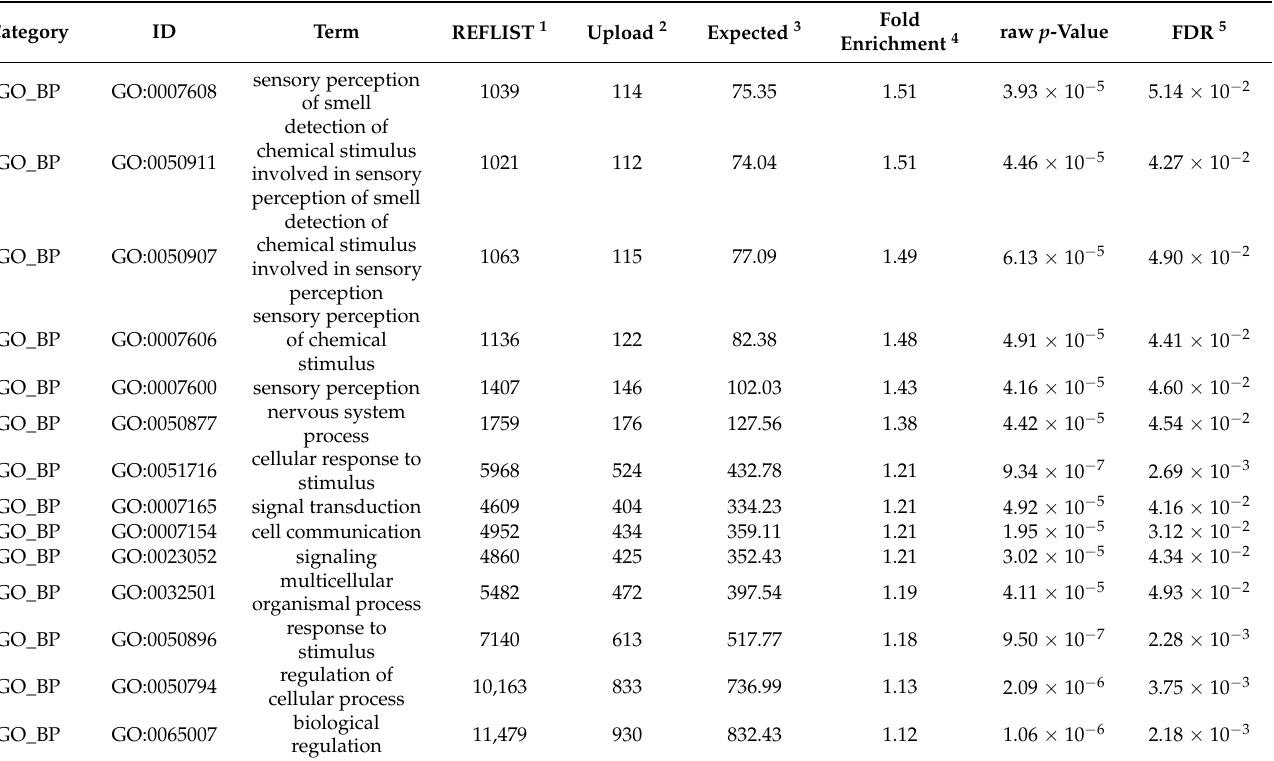
Table 4. Gene ontology (GO) terms (biological process) for annotated genes in copy number variation regions (CNVRs) of horses.